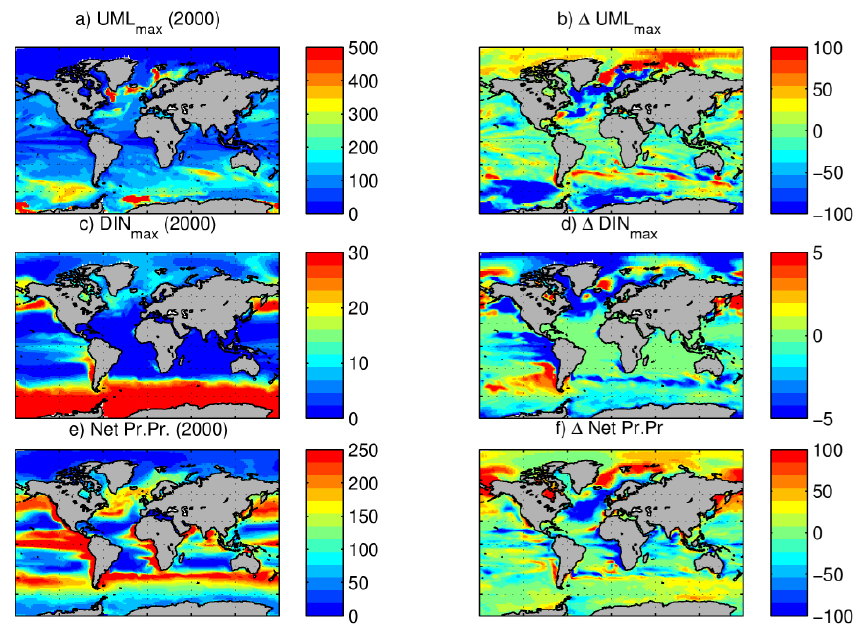
Fig. 9. Global surface maps of the upper mixed layer maximum ( a, b in m), surface DIN ( c, d in mmolm − 3 ), net primary production ( e, f in gCm − 2 yr − 1 ). Values are given for year 2000 (left column) and for deviation between year 2099 and year 2000 (right column).